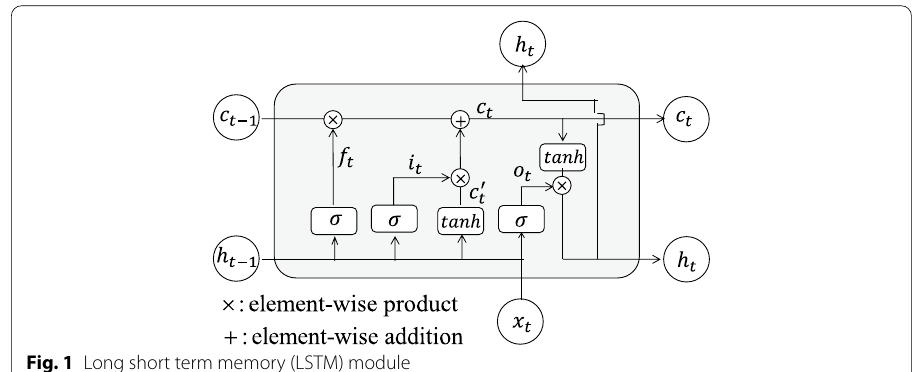
Fig. 1 Long short term memory (LSTM)